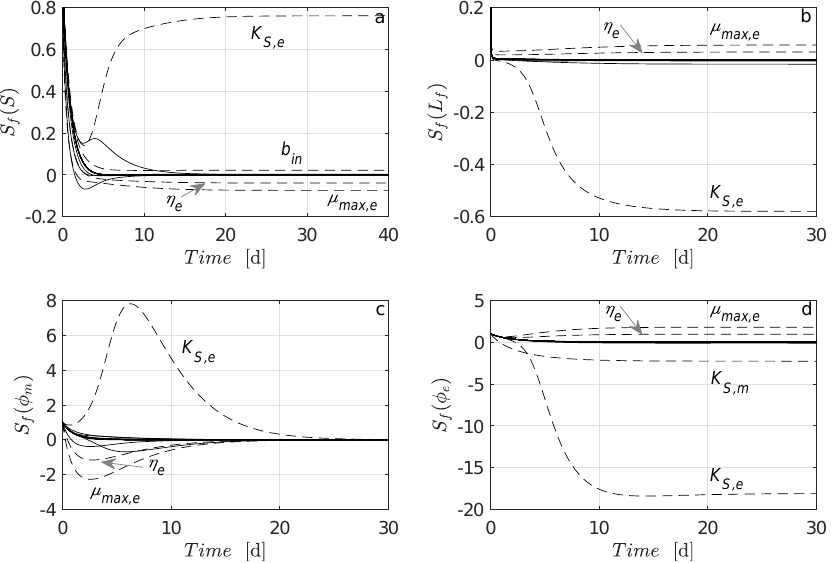
Figure 6. Numerical solution of Equation (22) for: ( a ) substrate, ( b ) biofilm thickness, ( c ) mass fraction of methanogenic microorganisms, and ( d ) mass fraction of exoelectrogenic